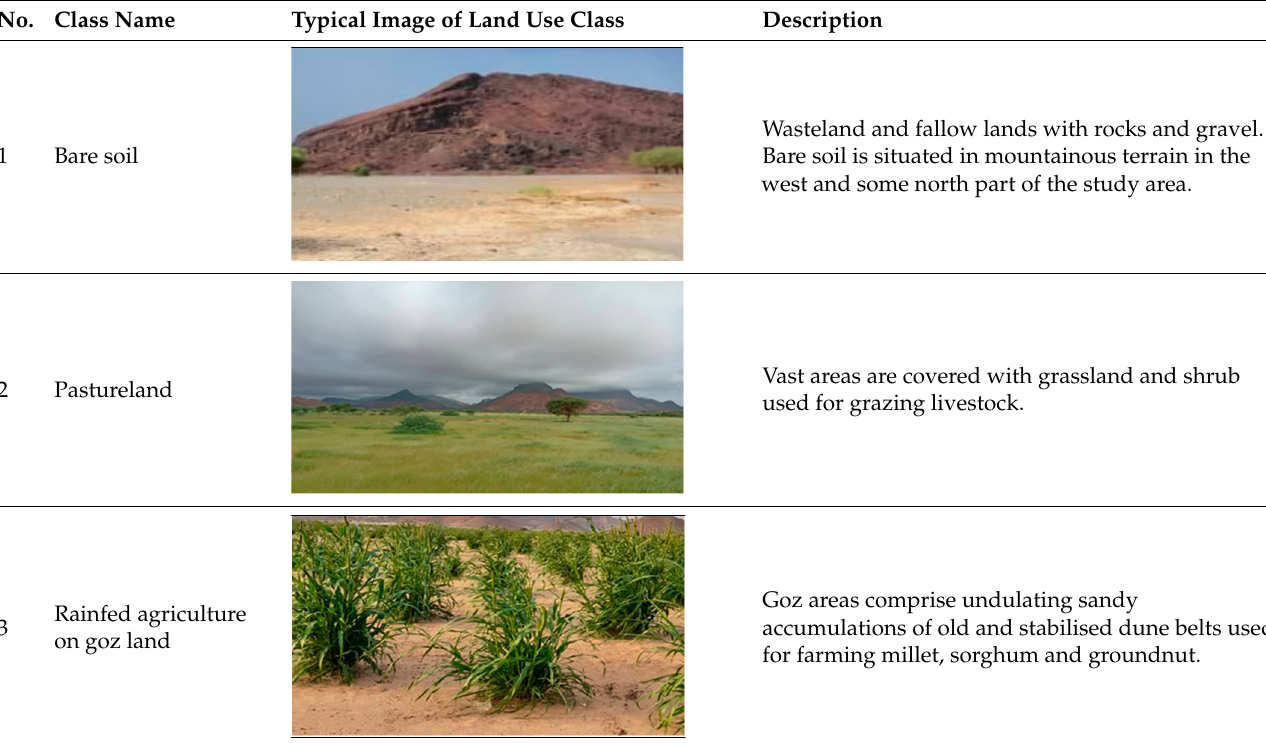
Table 1. Description of the land use and land cover (LULC) classes in the study area.